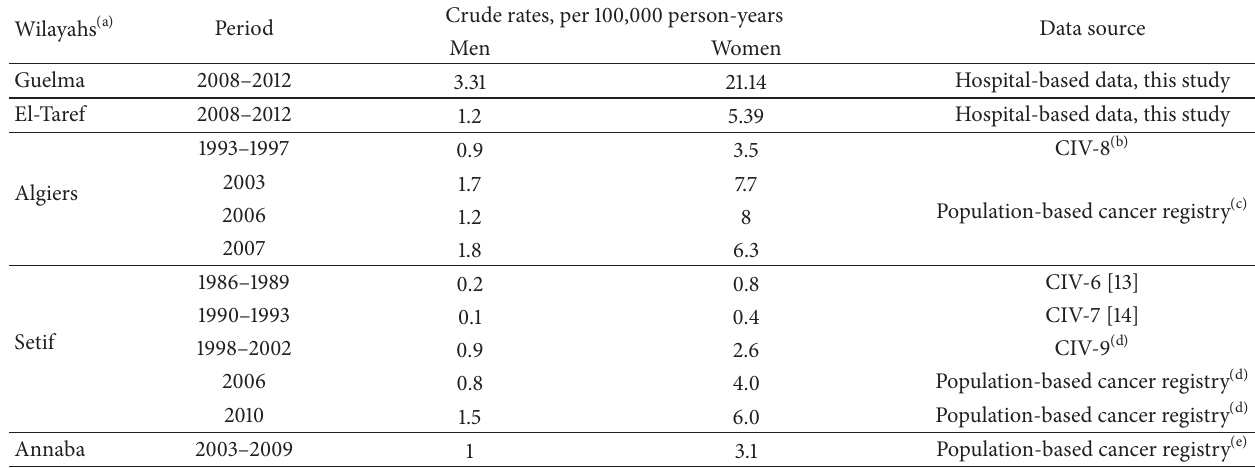
Table 2: Estimates of crude incidence rates of cancers of the thyroid in different Wilayahs of Algeria. Wilayahs ( a